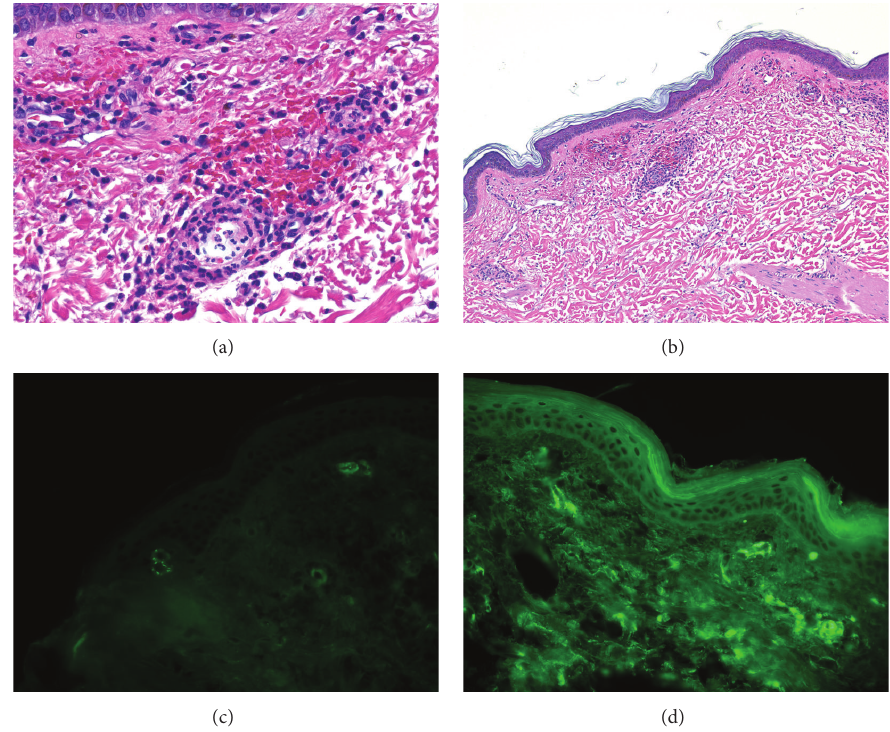
Figure 1: Skin biopsy, right arm. Top images are H&E slides of arm at high power (a) and low power (b), showing fibrin, neutrophils, and neutrophil fragments near vessels along with extravasated erythrocytes and a mixed cellular infiltrate. Bottom images are direct immunofluorescence (DIF) showing vascular wall staining with C3 (c) and IgA (d) supporting the diagnosis of HSP.